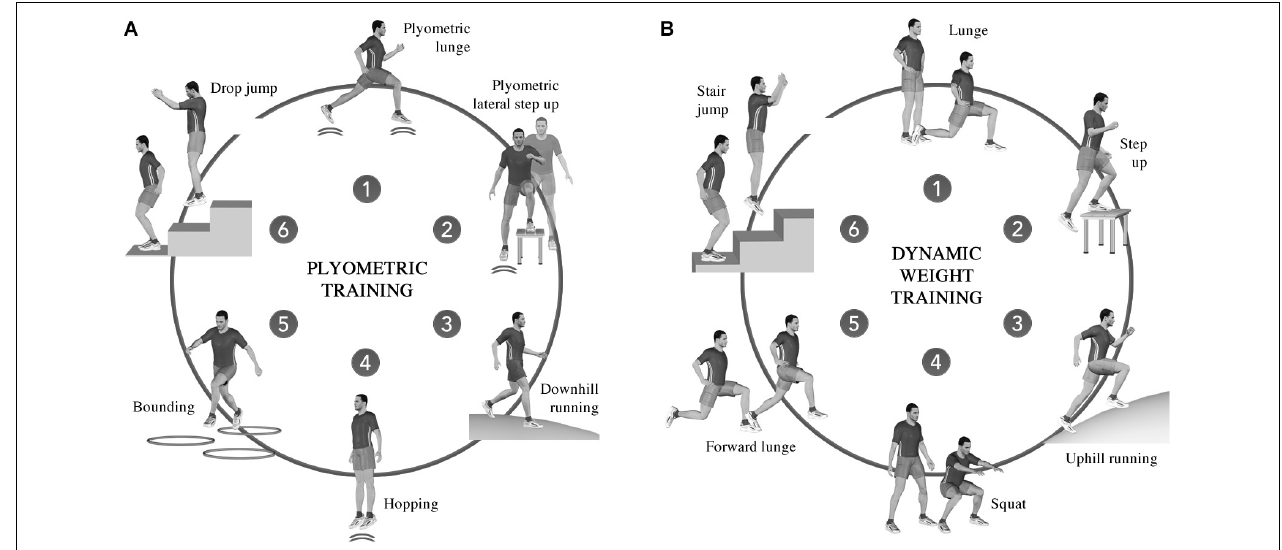
FIGURE 1 | Circuit training protocol for the plyometric training (A) and dynamic weight training (B) .